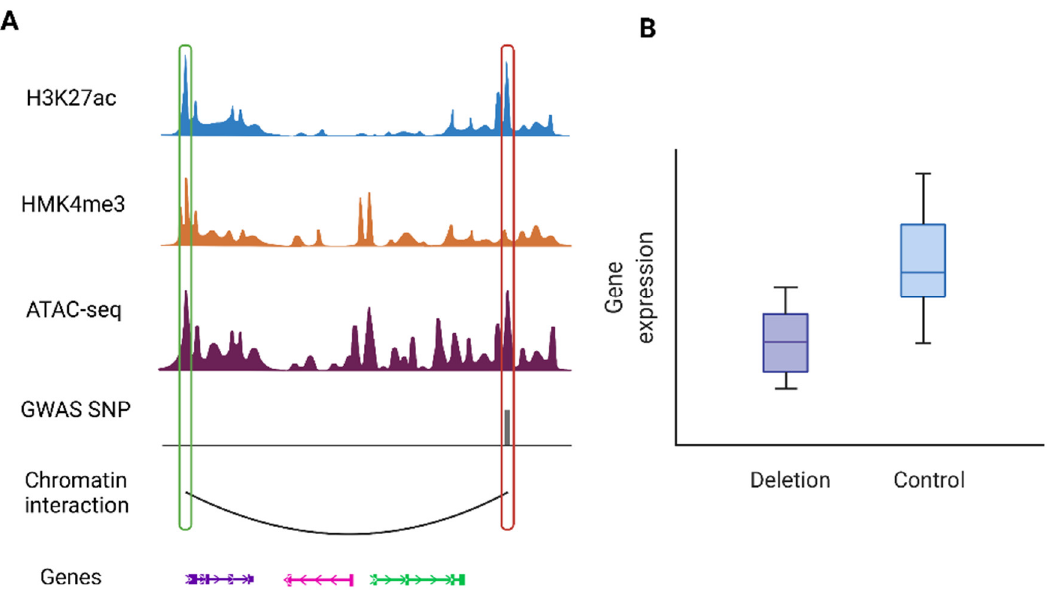
Figure 4. An illustrative example of a chromatin interaction involving disease-associated variants: ( A ) An example of a PIR containing a risk variant (highlighted by the red box on the right) with promoter region of the target gene (highlighted by the green box on the left). ( B ) Regulatory roles of the risk variant can be validated by downstream experiments such as CRISPR techniques. This example shows deletion of the PIR containing the risk variant results in downregulation of the target gene (the left most gene). The figure was inspired by results presented in Song et al. [61].